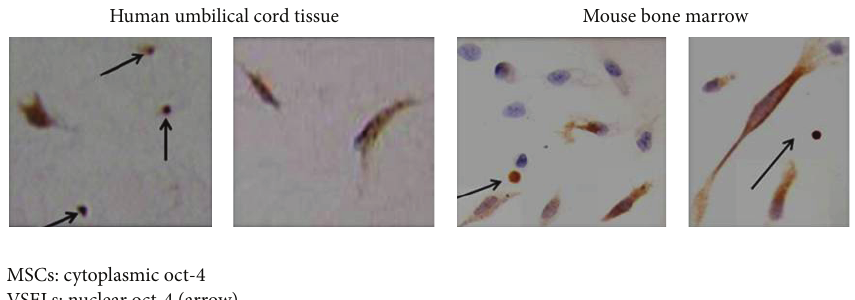
Figure 2: Immunolocalization of OCT-4 in MSCs and VSELs in human umbilical cord tissue sections and mouse bone marrow smears. Note that the round spherical VSELs have nuclear OCT-4, whereas the MSCs have cytoplasmic OCT-4.